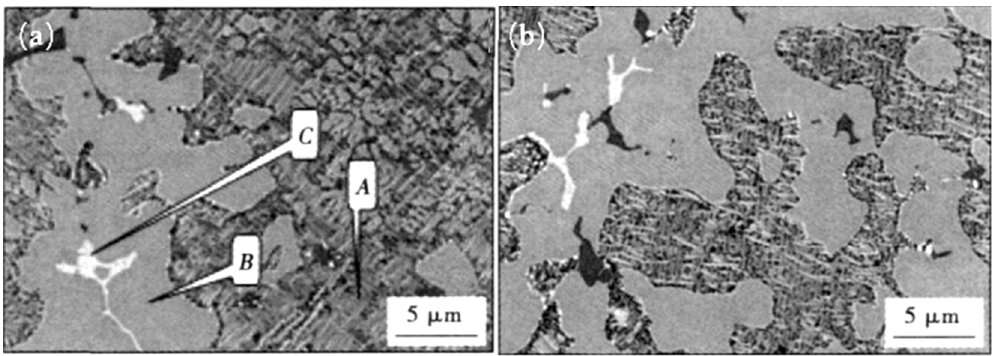
Figure 7. Microstructures of Cu-20Ag-Zn-xSn with ( a ) 6.5% and ( b ) 7.5% Sn [21].